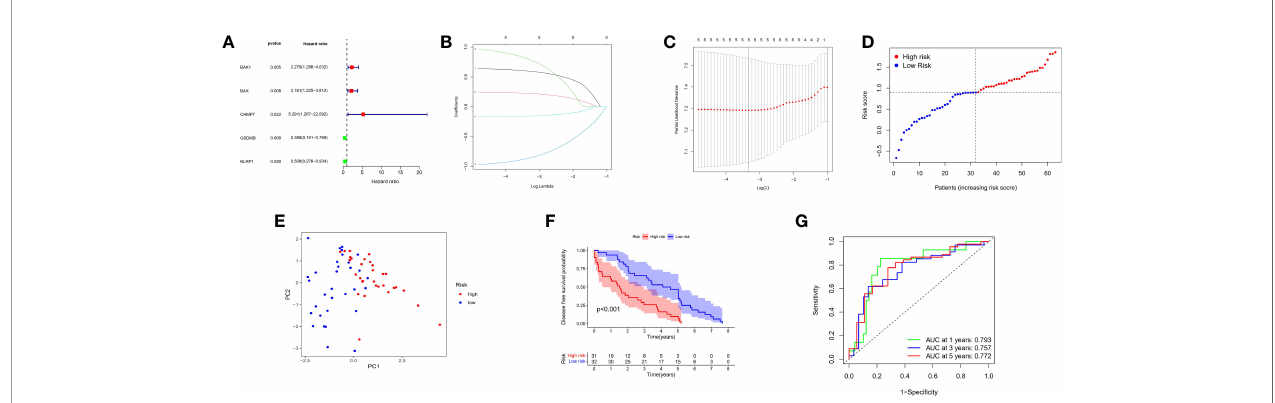
FIGURE 7 | Construction of risk signature in the GEO cohort. (A) Univariate cox regression analysis of DFS for each pyroptosis-related gene, and genes with P < 0.05. (B) LASSO regression of the 5 DFS-related genes. (C) Cross-validation for tuning the parameter selection in the LASSO regression. (D) Distribution of patients based on the risk score. (E) PCA plot for PCs based on the risk score. (F) Kaplan-Meier curves for the DFS of patients in the high- and low-risk groups. (G) ROC curves demonstrated the predictive sensitivity of the risk